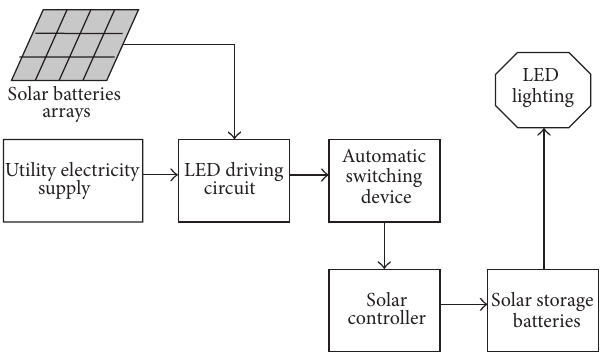
Figure 7: The diagrammatic sketch of solar Photovoltaic LED lighting